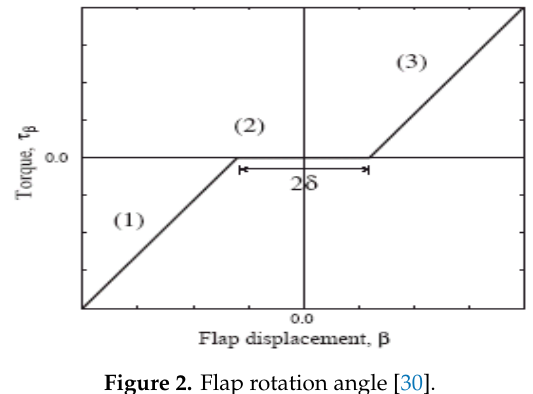
Figure 2. Flap rotation angle [30].